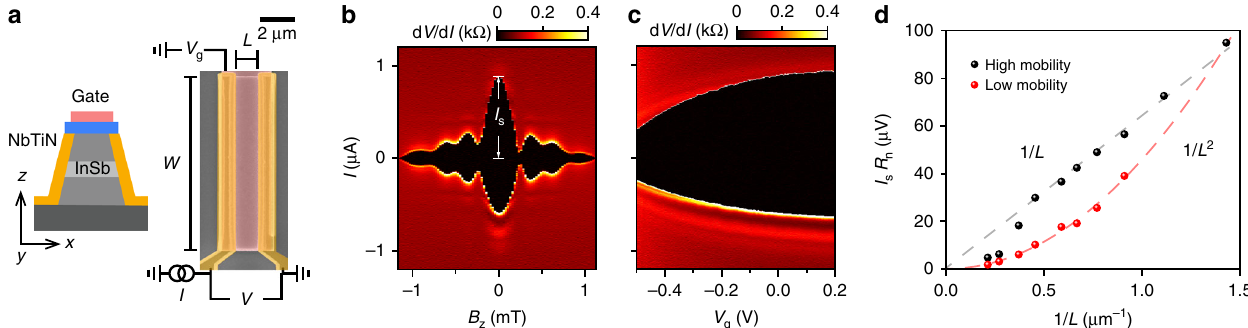
Fig. 1 Ballistic superconductivity in InSb 2DEGs. a Cross-sectional schematic and false-colored scanning electron micrograph (along with a measurement schematic) of a top-gated JJ of width W and length L . b Differential resistance, d V /d I , versus perpendicular magnetic fi eld, B z , and current bias, I , displaying a Fraunhofer-like interference pattern for a JJ with W = 9.7 μ m, L = 1.1 μ m. White line indicates the magnitude of the switching current, I s , at zero magnetic fi eld. c d V /d I as a function of I and gate voltage, V g , for the same JJ, showing gate control of I s . d Length dependence of I s R n for JJs on a high mobility (black dots) and low mobility (red dots) wafer, obtained at V g = 0 V. Dashed lines are 1/ L and 1/ L 2 fi ts to the data, indicating ballistic and diffusive